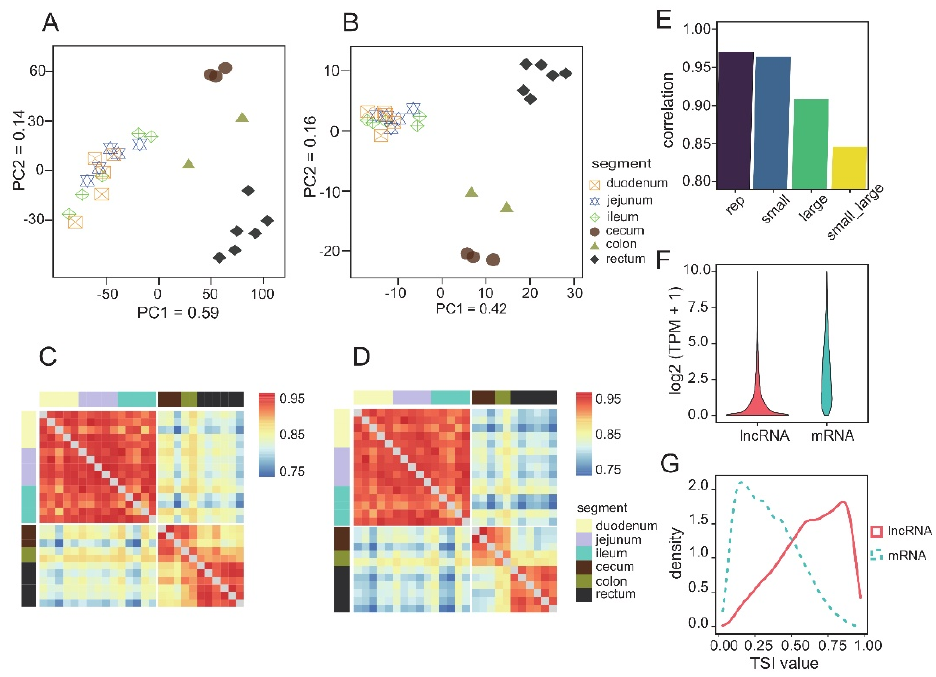
Figure 1. Transcriptome comparison of different intestinal segments. ( A ) PCA of PCGs and ( B ) lncRNAs. The proportion of the variance explained by the principal components (PCs) is indicated in parentheses; ( C ) Heat map showed the correlation of PCGs and ( D ) LncRNAs expression profiles among samples; ( E ) Mean Pearson correlation coefficients within different groups; ( F ) Expression level of PCGs and lncRNAs, TPM value transformed by log2 (TPM + 1); ( G ) Distribution curves of TSI values of PCGs and